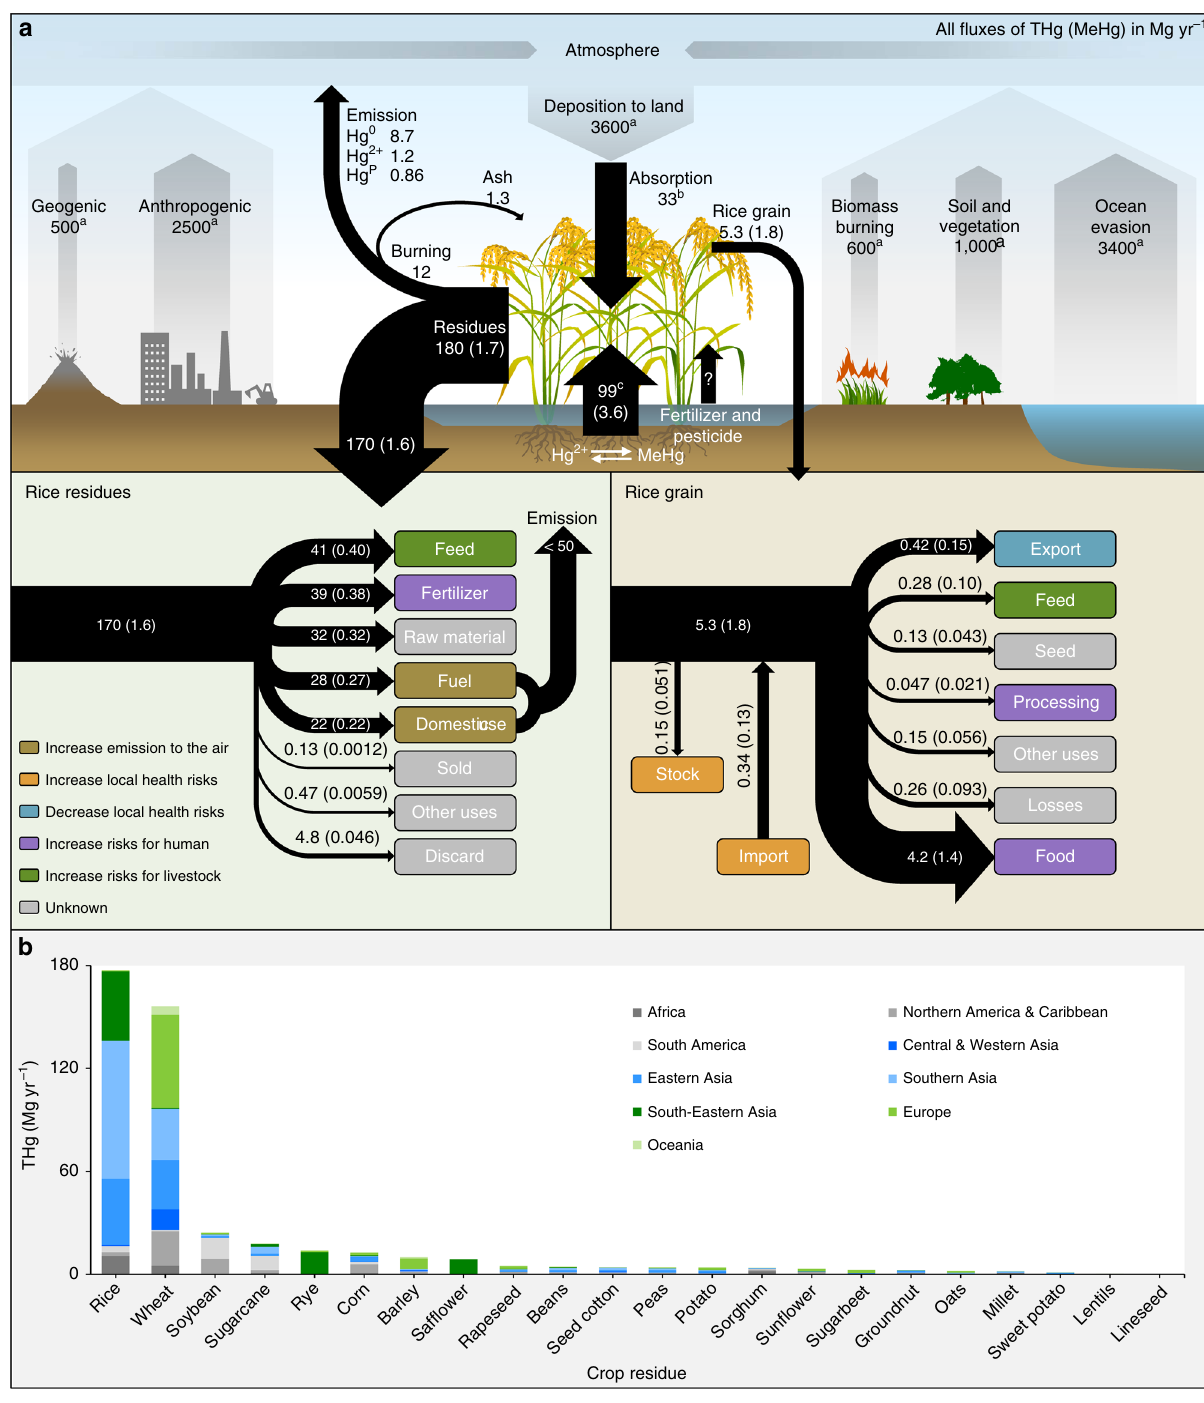
Fig. 7 Global biotransport of mercury through rice and other crops. a Global biotransport of THg and MeHg through production, trade, supply, and consumption of rice grain and through different management options of rice residues; b global THg generated in crop residues in 2016. In a , fl uxes of atmospheric THg emission and deposition refer to the study of Outridge et al. 31 ; the fl ux of root absorption of THg from soil was calculated based on the rice THg uptake fl ux synthesized by Kwon et al. 67 ; and the absorption of atmospheric Hg by rice leaves was estimated by the fl ux of Hg over foliage estimated by Wang et al. 68 . The global harvested area of rice was obtained from the FAO